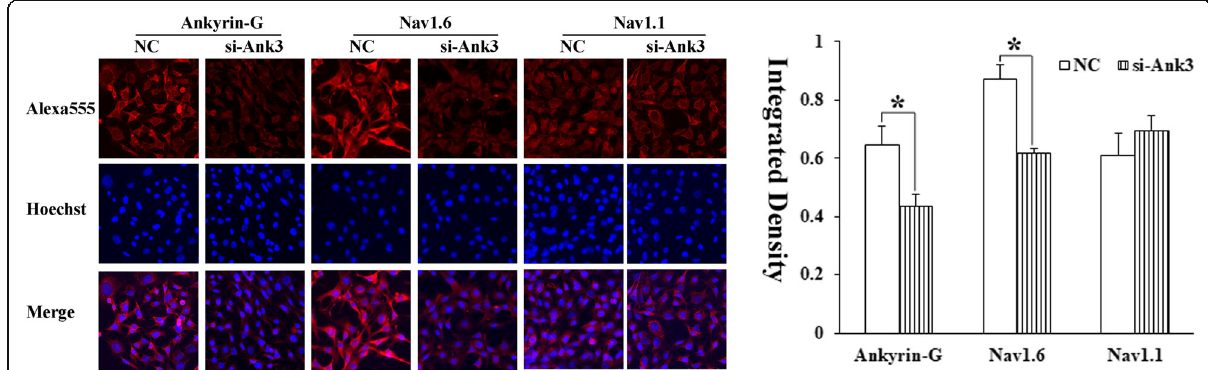
Fig. 3 Immunocellularchemistry assay for Ankyrin-G, Nav1.6 and Nav1.1 after siRNA interference in HT22 cells. In the representative sections, antibodies illustrate the localizing of Ankyrin-G, Nav1.6 and Nav1.1 labeled with Alexa555 in red and nuclei were revealed by Hoechst in blue. Quantification of Ankyrin-G revealed significant decrease of normalized integrated density after siRNA silence compared to NC group ( P < 0.05). Similar change of integrated density of Nav1.6 were detected ( P <